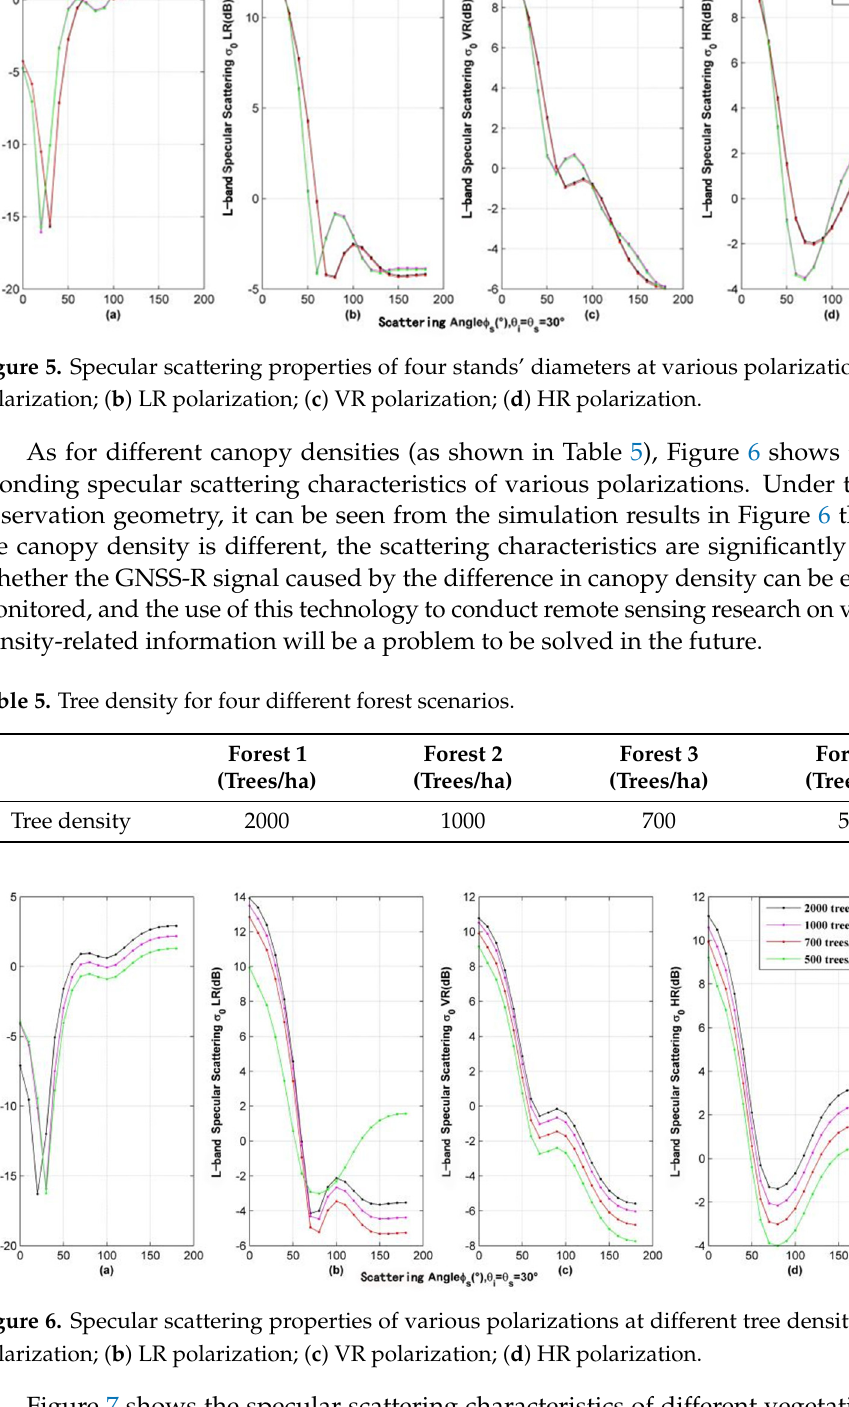
Figure 7. Specular scattering properties of various polarization for different vegetation water con- tents. ( a ) RR polarization; ( b ) LR polarization; ( c ) VR polarization; ( d ) HR polarization. Table 6. Vegetation water content and permittivity for the three scenarios. Trunk